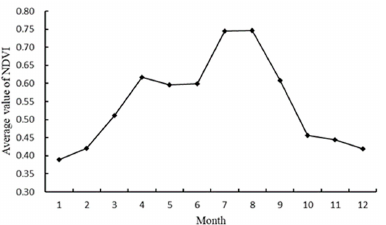
Figure 2. Monthly variation of NDVI in Anhui Province from 2001 to 2019.